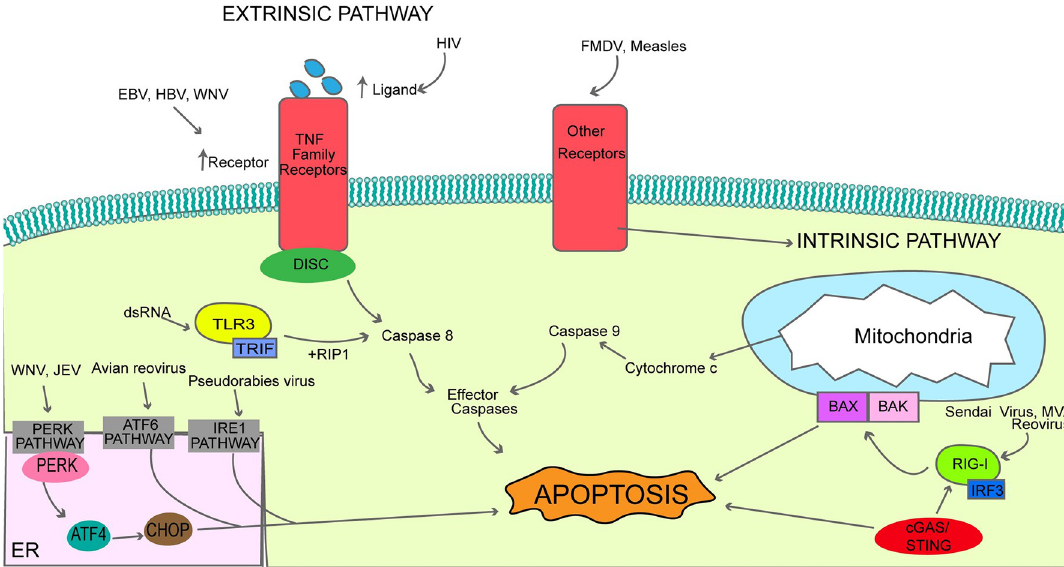
Fig 1. A summary of the major components of the extrinsic and intrinsic pathways of apoptosis induction following viral infection. In response to viral infection, the extrinsic pathway is initiated by death receptors following stimulation by the TNF proteins, resulting in downstream signaling and caspase-8 activation. The intrinsic pathway of apoptosis arises from proapoptotic stimuli, subsequently initiating mitochondrial membrane permeabilization and activation of caspase-9. Both pathways converge at the terminal activation of caspase-3 that executes apoptosis. ATF4 AU : AbbreviationlistshavebeencompiledforthoseusedinFigs 1 (cid:0) 3 : Pleaseverifythatallentriesarecorrect : , activating transcription factor 4; ATF6, activating transcription factor 6; BAK, BCL-2 antagonist or killer; BAX, BCL-2-associated X protein; cGAS/STING, cyclic GMP–AMP synthetase/stimulator of IFN genes; CHOP, CCAAT-enhancer-binding protein homologous protein; DISC, death-inducing signaling complex; EBV, Epstein–Barr virus; ER, endoplasmic reticulum; FMDV, Foot-and-mouth disease virus; HBV, hepatitis B virus; IRE1, inositol-requiring enzyme 1; IRF3, IFN- regulatory factor 3; JEV, Japanese encephalitis virus; MVA, modified vaccinia virus; PERK, PKR-like ER kinase; RIG-I, retinoic acid- inducible gene I; TLR3, Toll-like receptor 3; TNF, tumor necrosis factor; TRIF, Toll/IL-1 receptor domain-containing adapter inducing IFN-beta; WNV, West Nile